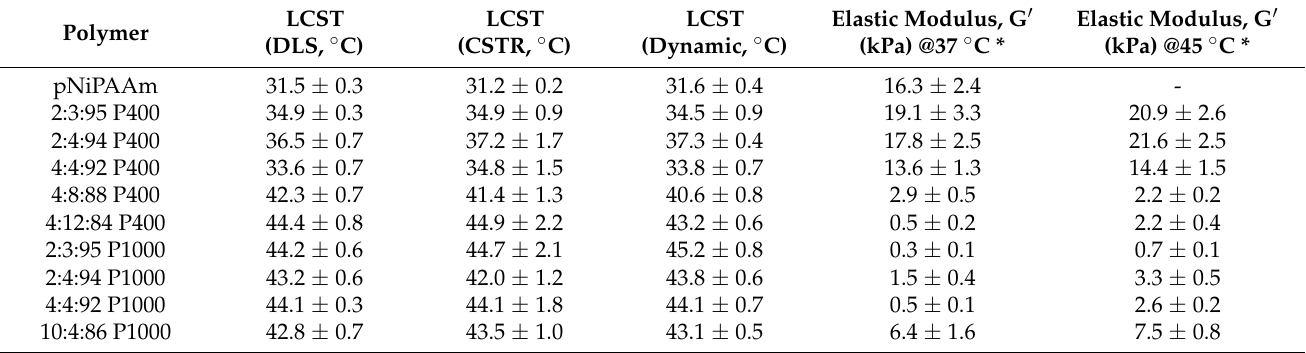
Table 3. Summary of thermal and mechanical properties of the different p(VPBA-co-PEGMMA- co-NiPAAm) terpolymers and pure pNiPAAm. LCST was determined by DLS, constant-stress temperature ramp (CSTR) viscosity measurements, and dynamic oscillatory shear measurements. Stiffness was measured by oscillatory experiment at 37 and 45 ◦ C. Average and variation calculated with n = 6, except for synthesis 2:3:95 P400, 2:4:94 P400, 4:4:92 P400, and 4:8:88 P400, where the sample number was n = 5. Average and variation for stiffness calculated with n = 3. The t -test result does not present a significant variation between the three different methods to calculate